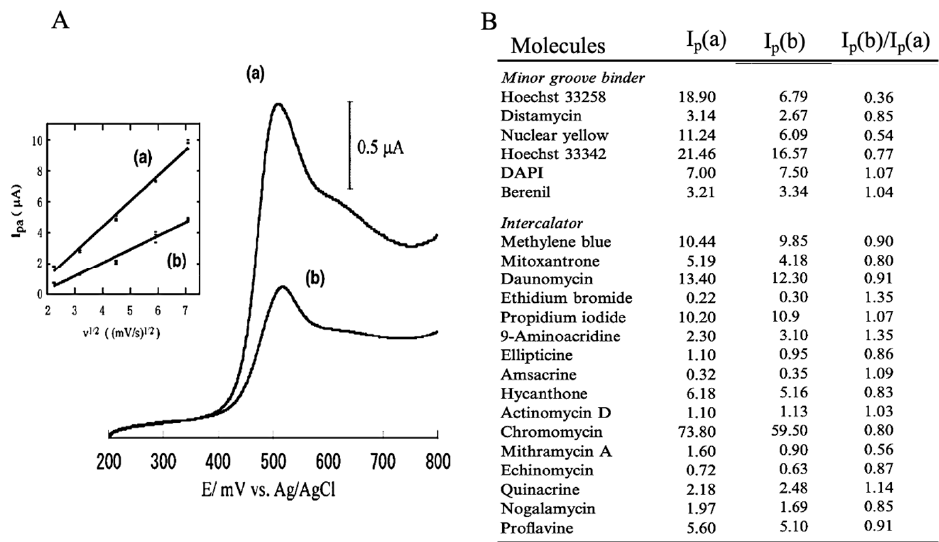
Figure 3. Comparison of electrochemical responses between DNA and various DNA-binding electrochemically active molecules [16] ( A ): Cyclic voltammograms with electrochemical indicator alone (a) and in the presence of DNA (b). ( B ): Comparison of I p (a), I p (b) and I p (b)/I p (a) among DNA-binding molecules. I p (a) and I p (b) indicated peak currents at (a) and (b) respectively.